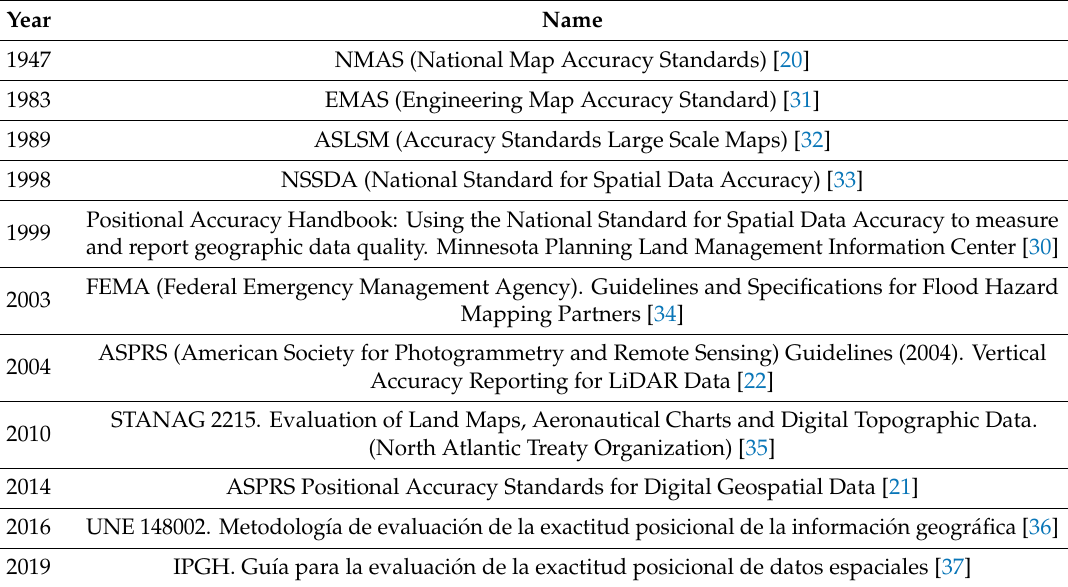
Table 2. Standards